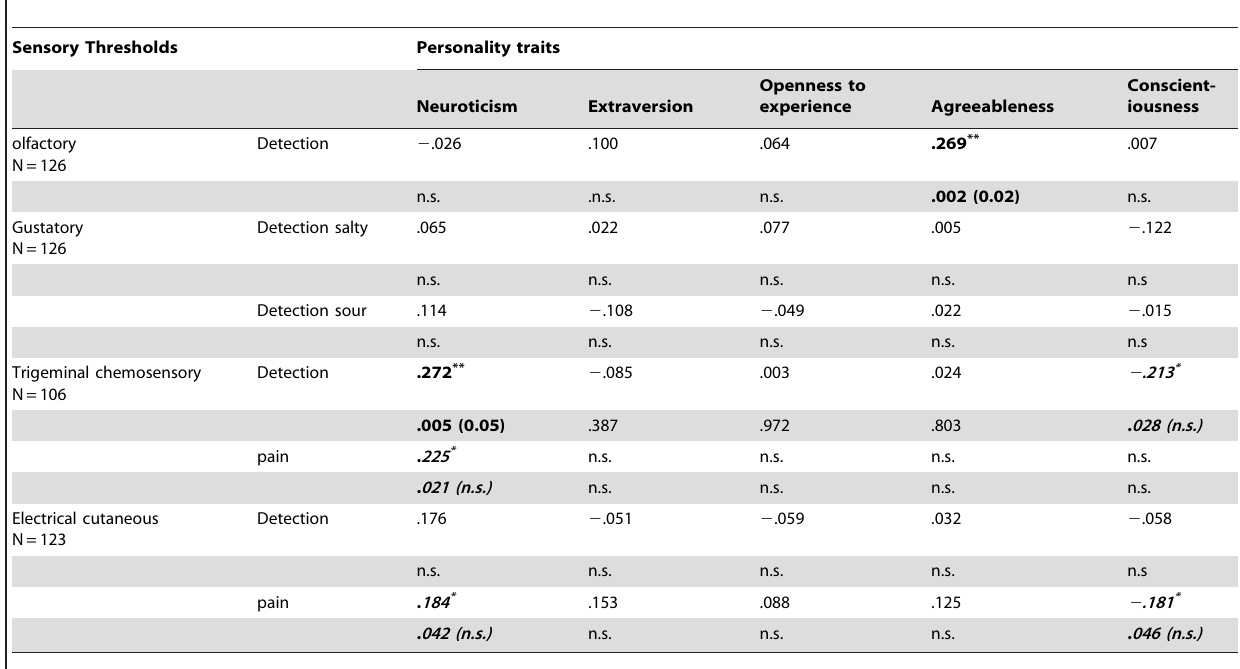
Table 2. Pearson’s correlation coefficients between personality traits and sensory detection and pain